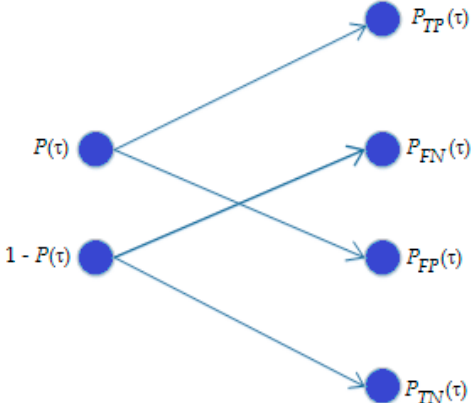
Figure 1. Graph of decision-making when monitoring the condition of the wind turbine (WT) component in the interval (0, τ ), where P ( τ ) is the probability that the WT component will be in the operable state in the interval (0, τ ), P TP ( τ ) is the probability that the component will not fail during the interval (0, τ ), and the sensors will not give an alarm (true positive), P FP ( τ ) is the probability that the component will not fail during the interval (0, τ ), and the sensors will give an alarm (false positive), P TN ( τ ) is the probability that the component will fail, and the sensors will alarm (true negative), and P FN ( τ ) is the probability that the component will fail, but the sensors will not trigger an alarm (false negative).